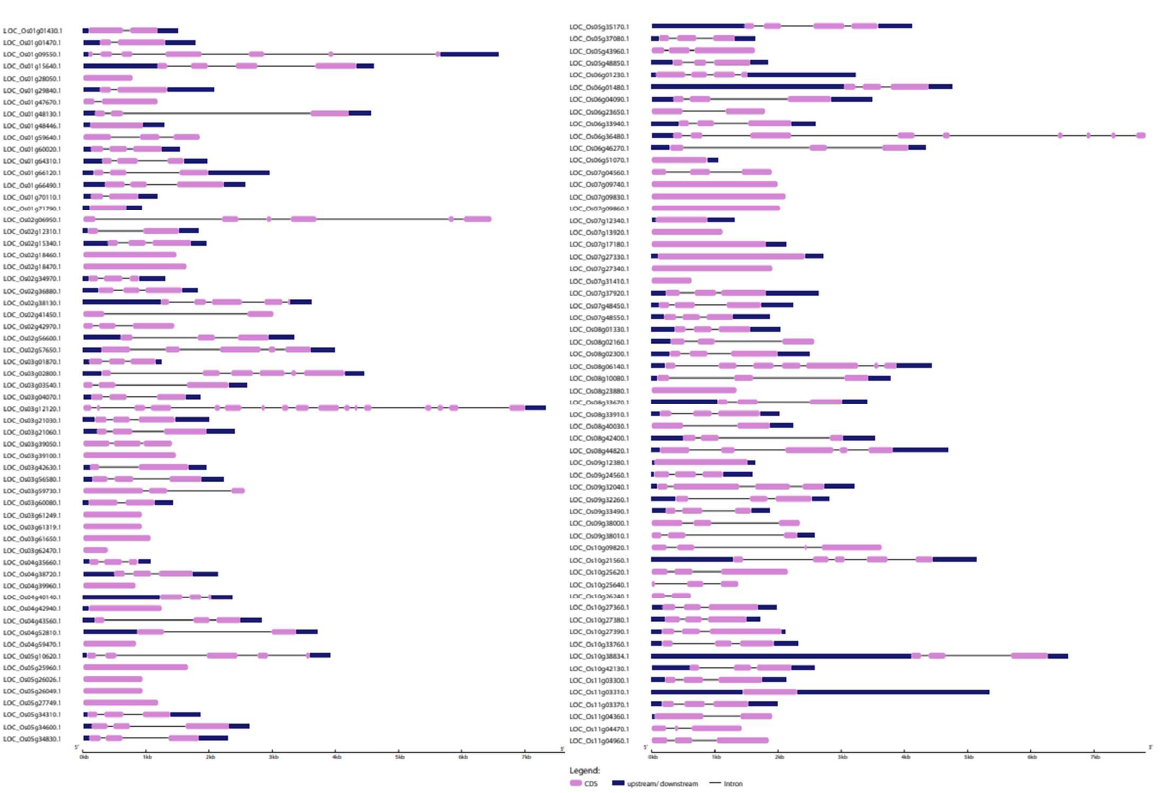
Figure 6. Exon–intron structure analysis of Oryza sativa NAC genes was performed with the GSDS database. The dark blue boxes indicate upstream/downstream, the purple boxes indicate exons, and the black lines indicate introns.